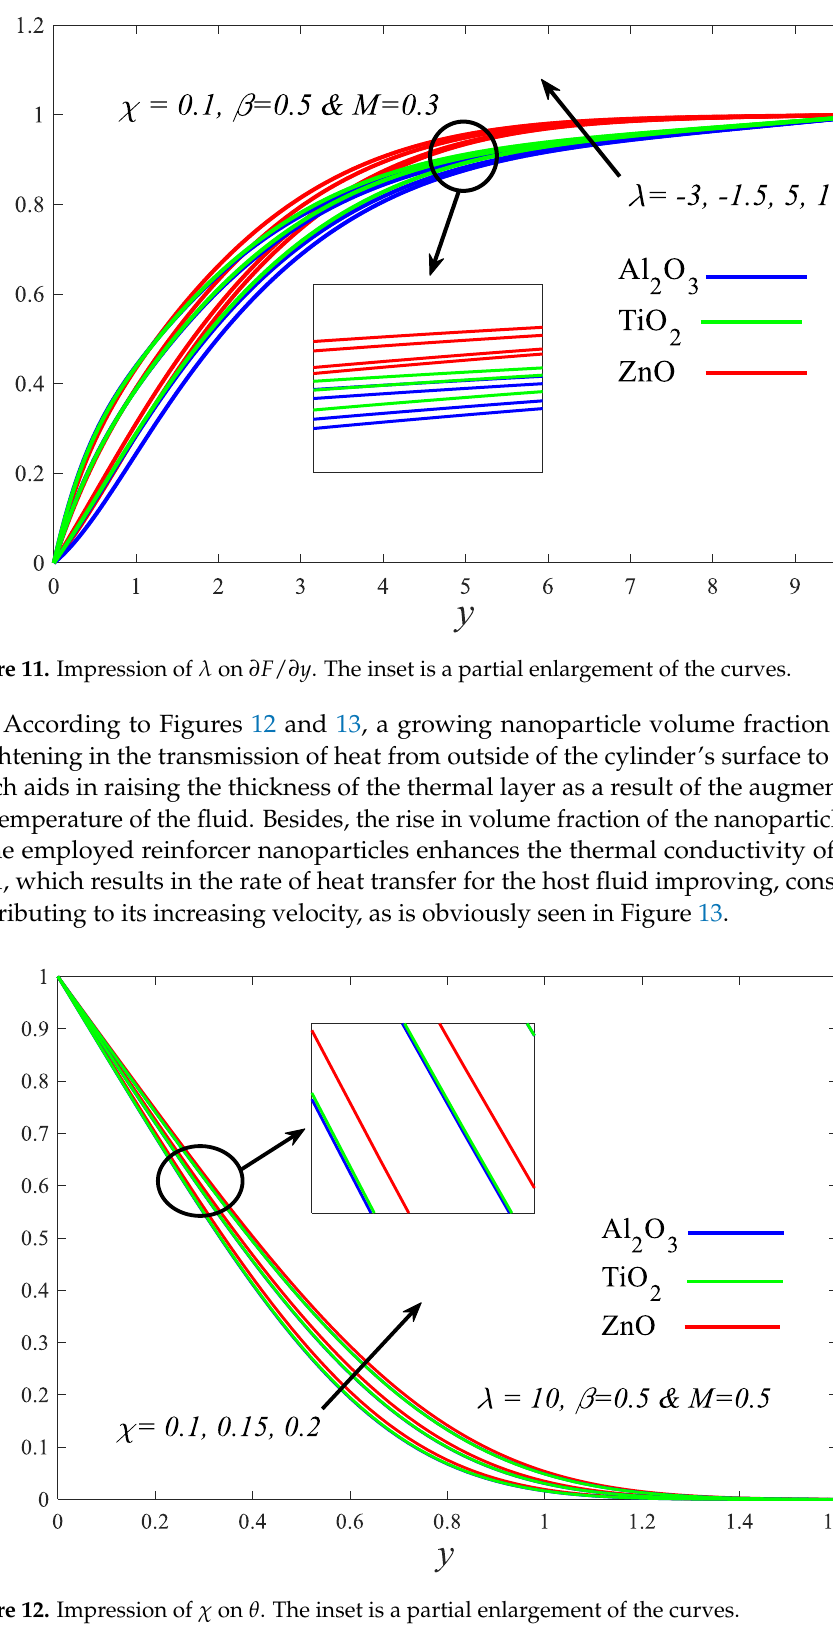
 Figure 10. Impression of on  . The inset is a partial enlargement of the curves.